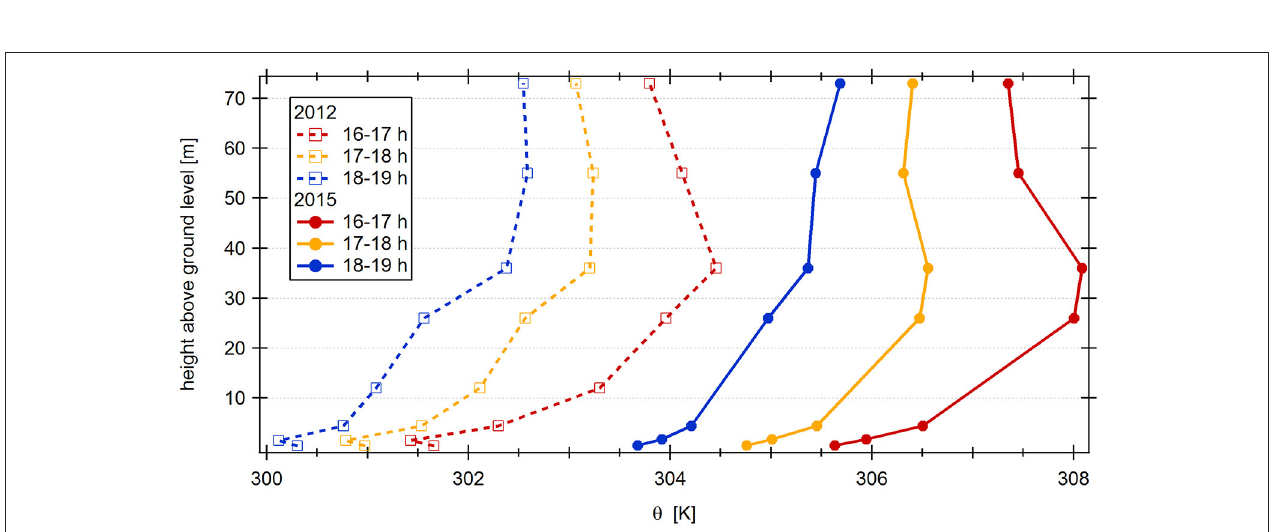
FIGURE 6 | Vertical potential temperature profiles between forest floor and 73m height above ground level for November 2012 and November 2015. Three different profiles represent temporal variation for the evening hours (local time).